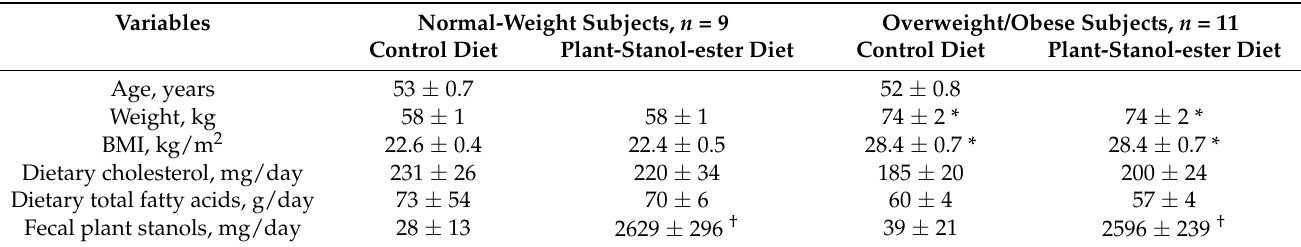
Table 1. Characteristics of the study population divided into normal-weight (BMI ≤ 25 kg/m 2 ) and overweight/obese (BMI > 25 kg/m 2 ) subjects during the control and plant stanol ester diets.